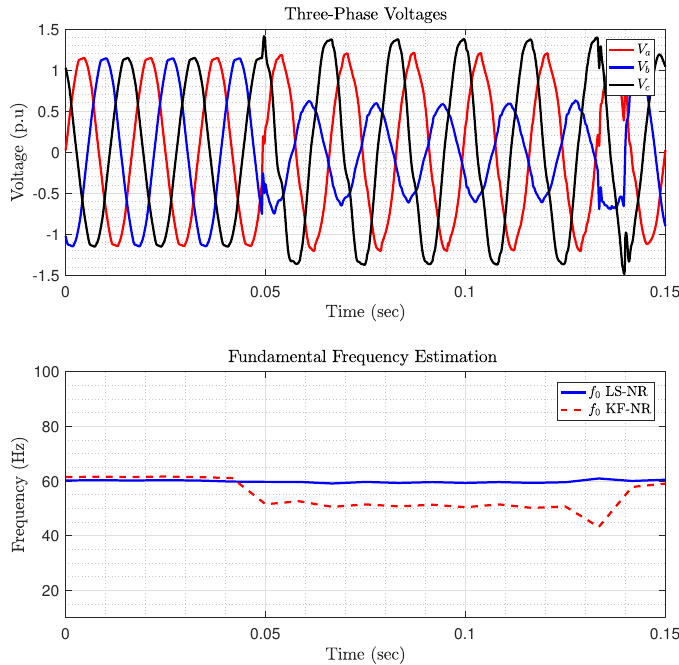
Figure 8. Three-phase voltages and estimated frequency (event